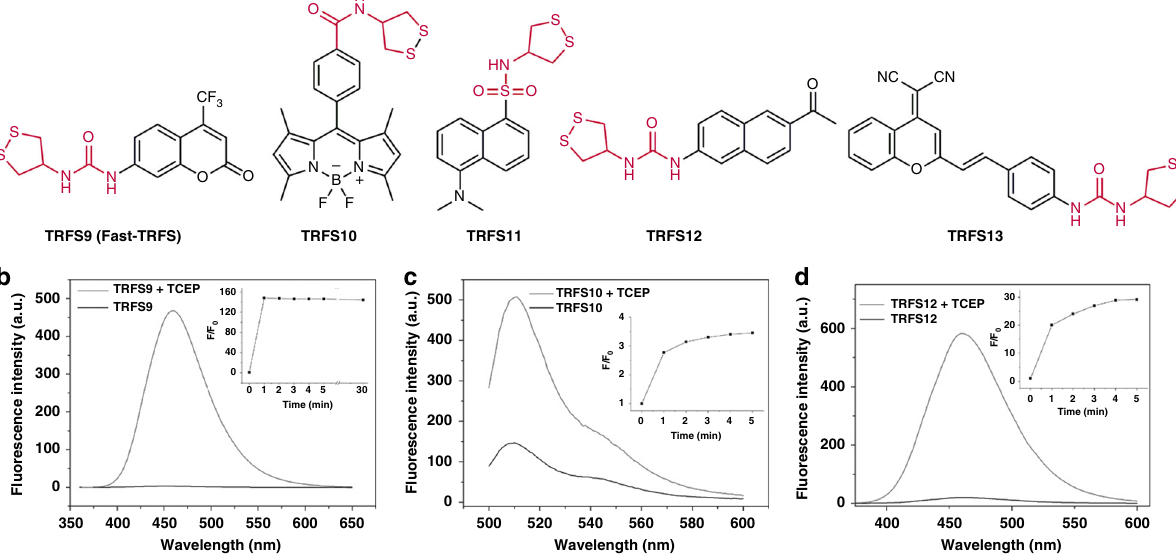
Fig. 5 Structures of TRFS9-13 and their response to TCEP. a Structures of TRFS9-13.The probes (10 μ M) were incubated with TCEP (1 mM) at 37 °C in TE buffer. The time-dependent emission spectra were recorded. b λ ex = 345 nm; c λ ex = 490 nm; d λ ex = 324 nm. The insets in b – d showed the time- dependent changes of emission at 460 nm, 510 nm, and 460 nm, respectively. Source data are provided as a Source Data fi